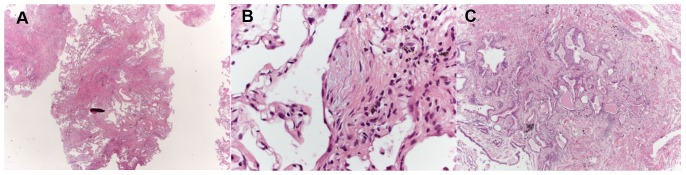
Different Examples of Cryobiopsy Showing UIP pattern.A) A low-magnification image showing dense scarring obliterating the alveolar architecture and abruptly alternating with relatively normal lung (patchy fibrosis). Some fibroblastic foci are visible even at this magnification for their pale-gray color. B) Fibroblastic focus better visualized at higher magnification. C) An area of honeycombing.